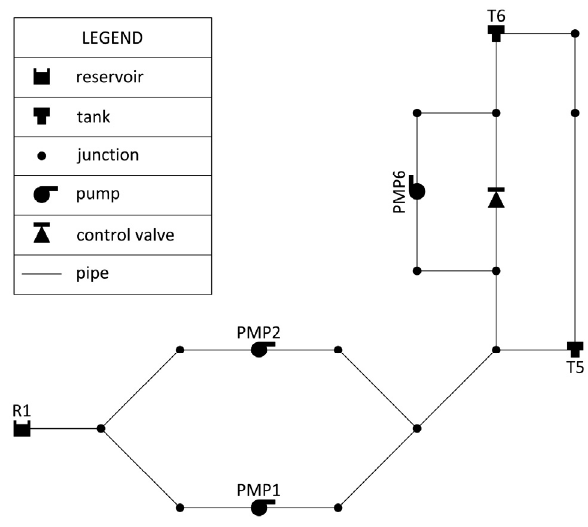
Figure 3. Van Zyl water distribution network model